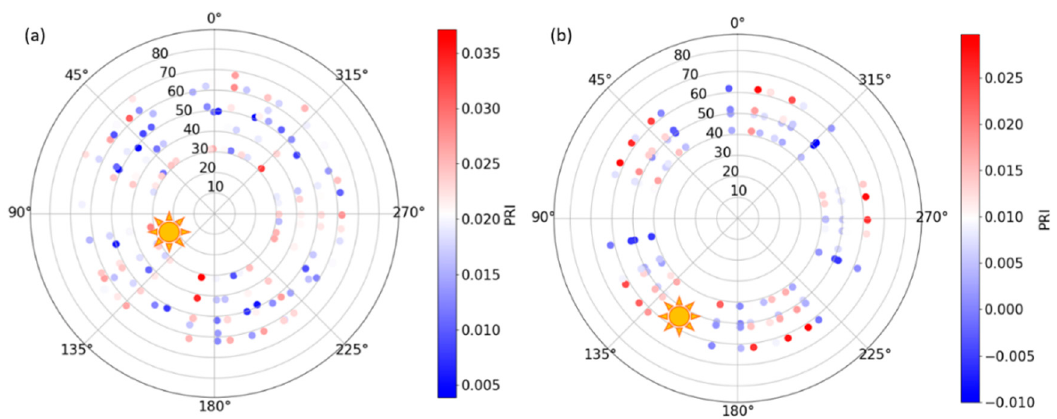
Figure 3. Observed PRI shown in a polar coordinate system (overhead view) obtained during 10:30– 10:45 on 13 July 2014 ( a ) and on 13 November 2014 ( b ), respectively. The yellow signs represent the solar position in the hemisphere, which is described by the solar azimuth angle (SAA) and solar zenith angle (SZA). The PRI was obtained at different viewing zenith angles (VZA: ranged from 0–90°) with varied viewing azimuth angles (VAA: ranged from 0–360°).